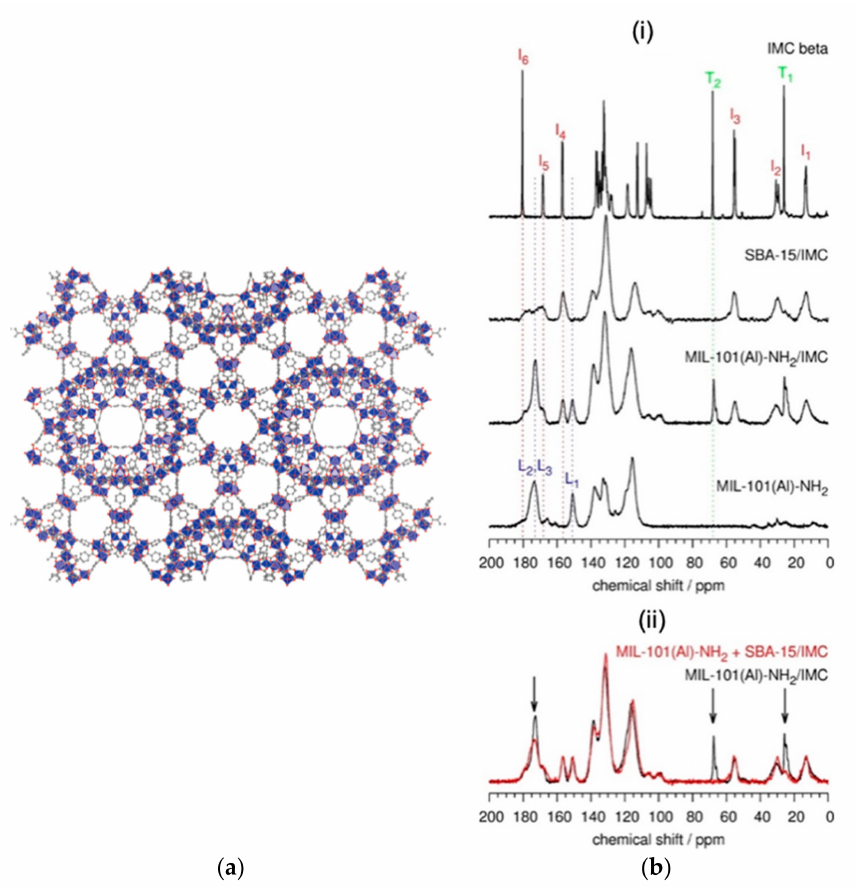
Figure 8. ( a ) Structure of MIL-101 viewed along the (101) direction. ( b ) ( i ) 1 H − 13 C CPMAS NMR spectra of bulk crystalline β - IMC, SBA-15/IMC, loaded and empty MIL-101(Al)-NH 2 . Peak labels correspond to selected carbon atoms within the IMC molecule (I1 − I6), THF molecule (T1, T2), and BDC-NH 2 linker (L1 − L3). Vertical dotted lines enable an easier comparison of signal positions. ( ii ) Comparison of the 1 H − 13 C CPMAS NMR spectrum of MIL-101(Al)-NH 2 /IMC with the sum of the spectra of SBA-15/IMC and MIL-101(Al)-NH 2 . Arrows indicate details where the differences are the most pronounced [31]. (Reprinted with permission from T. ˇCendak, E. Žunkoviˇc, T. Ukmar Godec, M. Mazaj, N. Zabukovec Logar, G. Mali, J. Phys. Chem. C 2014 , 118, 6140. Copyright © 2014, American Chemical